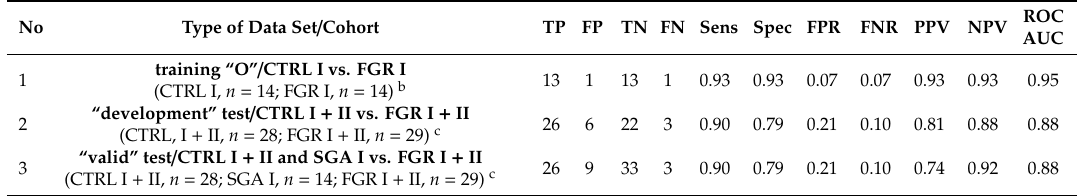
Table 2. Summary of biostatistic evaluation of individual patients a